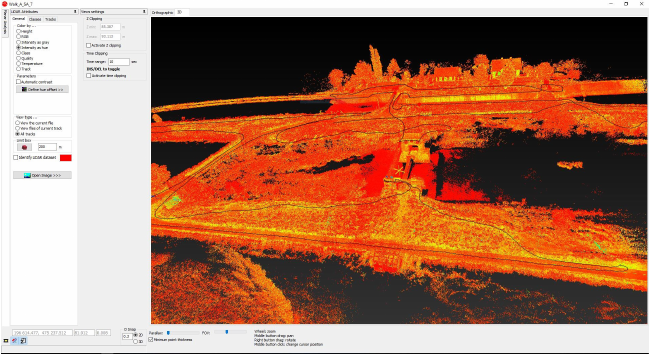
Figure 17. Intensity of LiDAR data nuance, Sânmihaiu Roman Lock, scan performed on 2 May 2019.